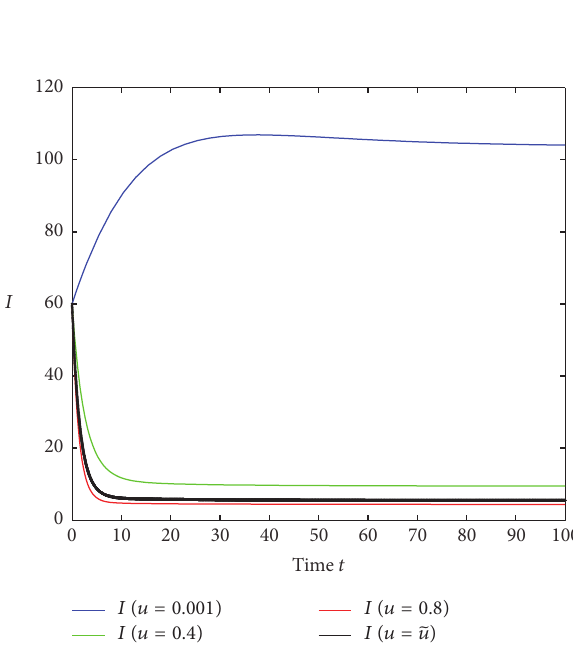
Figure 6: Evolution of number of infected computers with different control strategies.